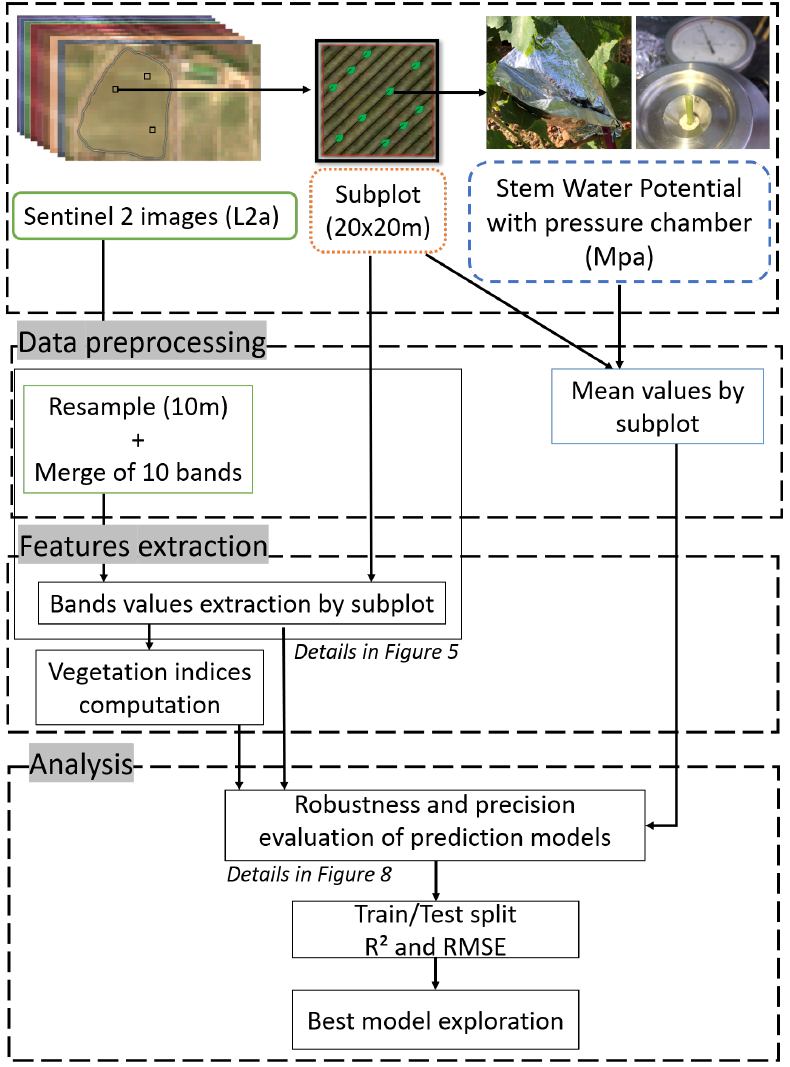
Figure 1. Flowchart of the method from the features extraction to the analysis